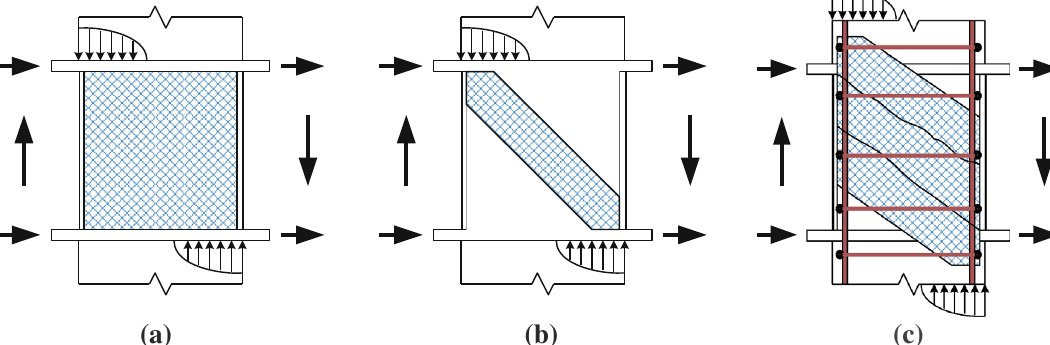
Fig. 2 Shear resistance mechanism for connections in various RCS composite systems: a steel beam web, b inner concrete strut, and c compression filled in external concrete element.